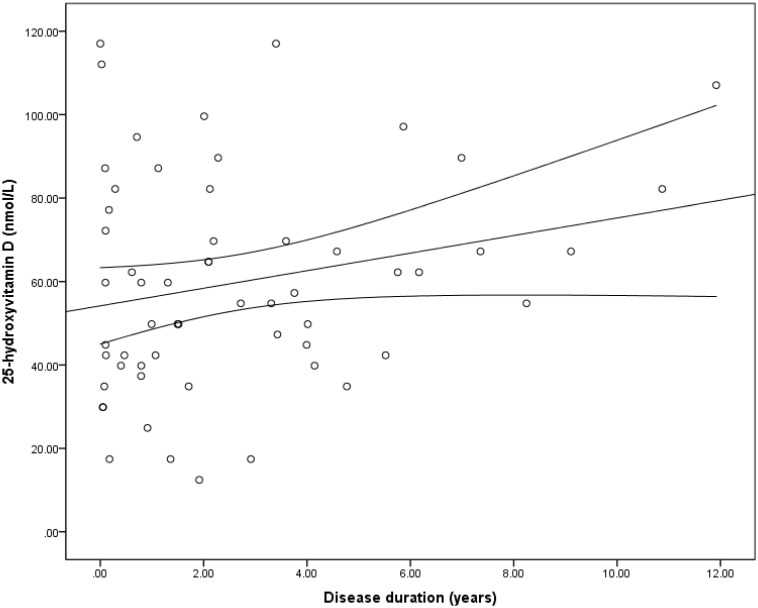
Scatterplot of the comparison of the 25-hydroxyvitamin D concentration and the duration of disease in inflammatory bowel disease.This figure shows a non-significant positive relationship between serum 25(OH)D concentration and the duration of disease (r2 = 0.054, β = 0.23, p = 0.08).